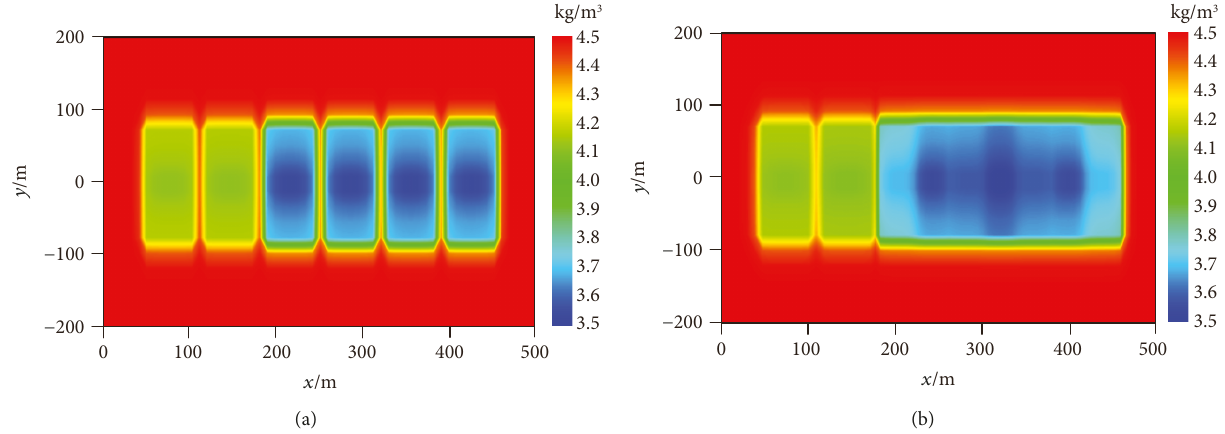
Figure 10: Reservoir adsorption gas content distribution: (a) refracturing through existing perforation clusters and (b) refracturing through new perforation zones.